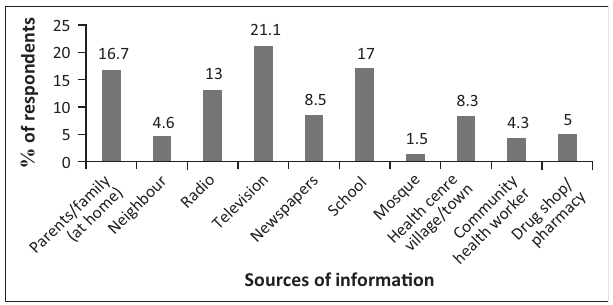
FIGURE 6: Reasons for not visiting an eye care professional in the past 12